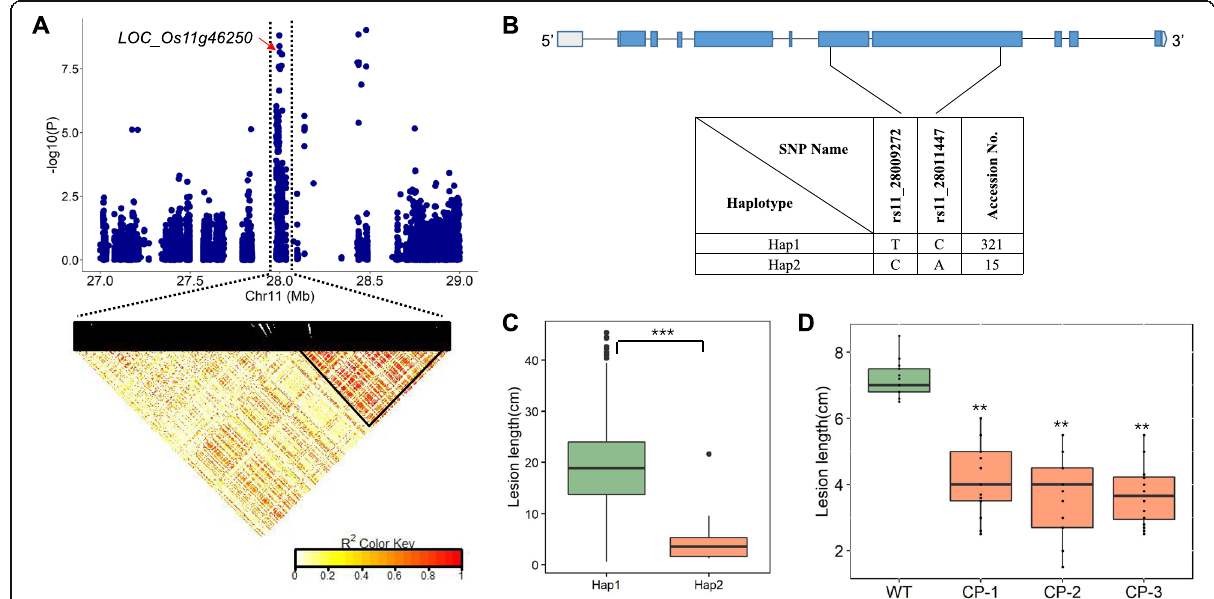
Fig. 4 Analysis of associated region of qC5 – 11.1 and its candidate gene LOC_Os11g46250 . a Manhattan plot (top) and linkage disequilibrium heatmap (bottom) of genomic region surrounding qC5 – 11.1 . The red arrow indicates the position of significant SNPs located in LOC_Os11g46250. b Exon-intron structure and haplotypes of LOC_Os11g46250 derived from significant SNPs. Rectangles and lines represent exons and introns, respectively and the coding sequence highlighted in blue. c Lesion length (LL) of accessions with different haplotypes of LOC_Os11g46250 inoculated with strain C5. d LL of transgenic lines and wild-type inoculated with C5. Box edges represent the 0.25 and 0.75 quantiles with median values indicated by bold lines. ** and *** refer to significant differences at P < 0.01 and 0.001, respectively. WT and CP-1/CP-2/CP-3 refer to wild- type Nipponbare and three independent transgenic lines carrying complementary genomic fragments,